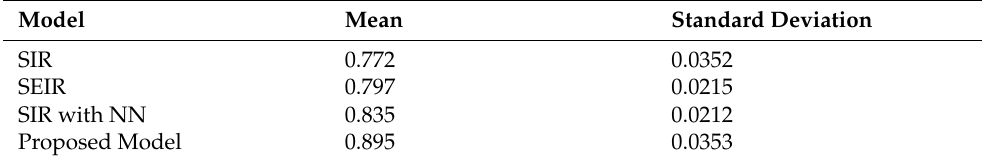
Table 4. Comparison between previous models.